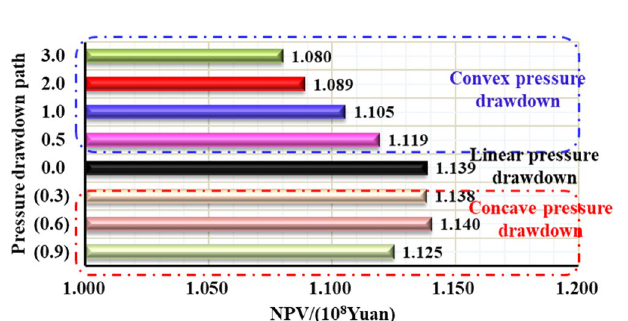
Figure 38. 20-year NPV chart under different pressure drop